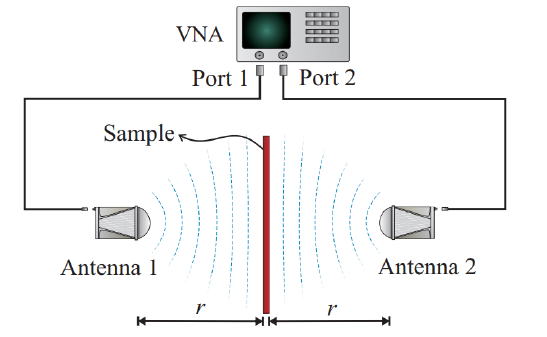
Figure 12. Free Space measurement method representation for obtaining transmission and reflection parameters. The sample is placed between two antennas, which are connected to the ports of the VNA